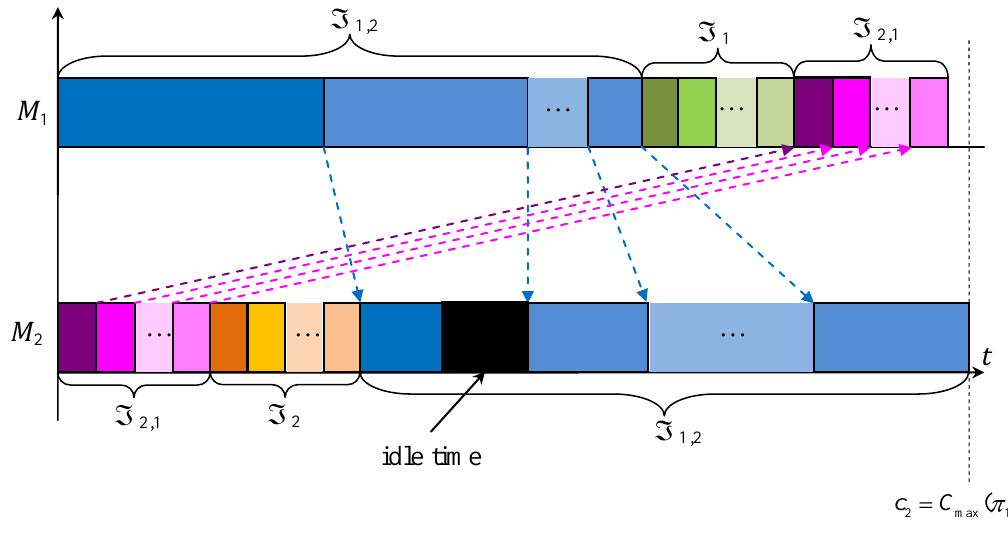
Figure 2. The optimal semi-active schedule for the job-shop scheduling